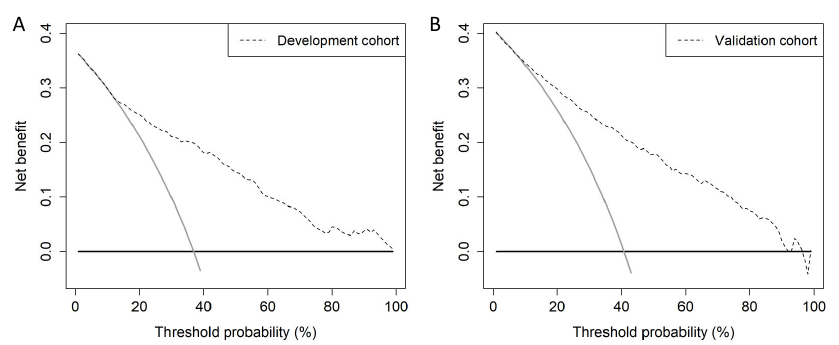
Figure 4. Net benefit of BCN ‐ RC 1 over performing MRI scans represented through decision curve analysis in all men in the development cohort ( A ) and the validation cohort ( B ).